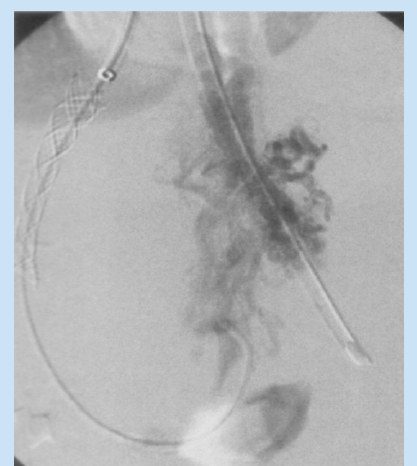
Fig. 2a. After placement of the stent the check portogram demonstrates persistent filling of collat- eral veins and varices via the coronary vein.